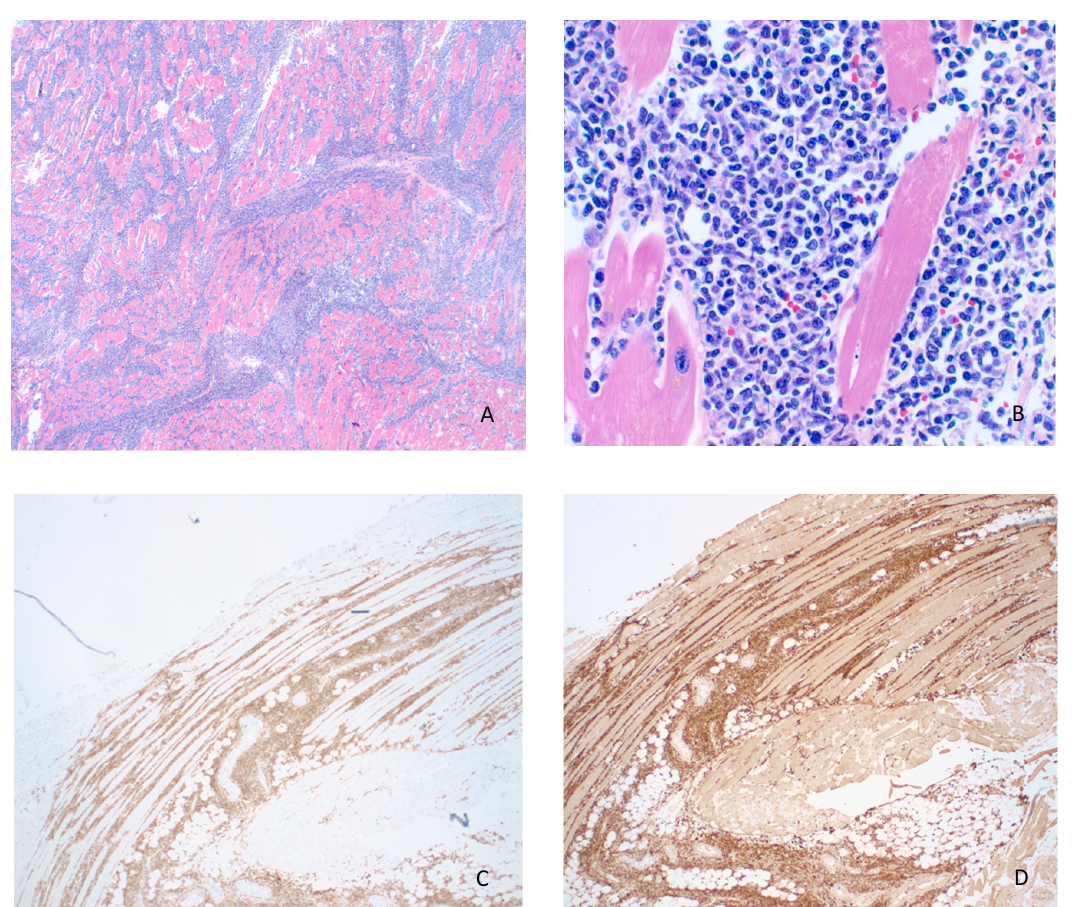
Figure 2. ( A ) Adult T-cell leukemia / lymphoma (ATLL) infiltration of endocardium and myocardium (H&E, 20 × ). ( B ) Higher magnification of infiltrating lymphoma showing pleomorphism, scant eosinophilic cytoplasm, irregular nuclear contours with coarse chromatin and variably prominent nucleoli (H&E, 200 × ). The lymphoma cells were strongly positive for CD4 ( C ) and CD25 ( D ) by immunohistochemistry (20 × ).